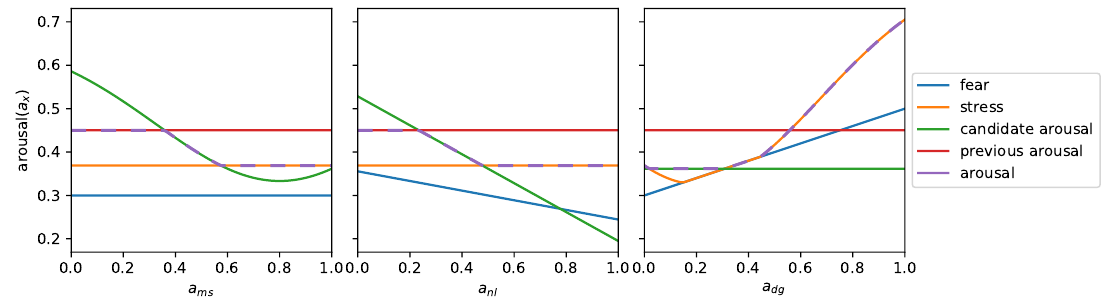
Figure 9. Plots showing the calculation of arousal as it depends on other functions. Each plot shows arousal in function of a different